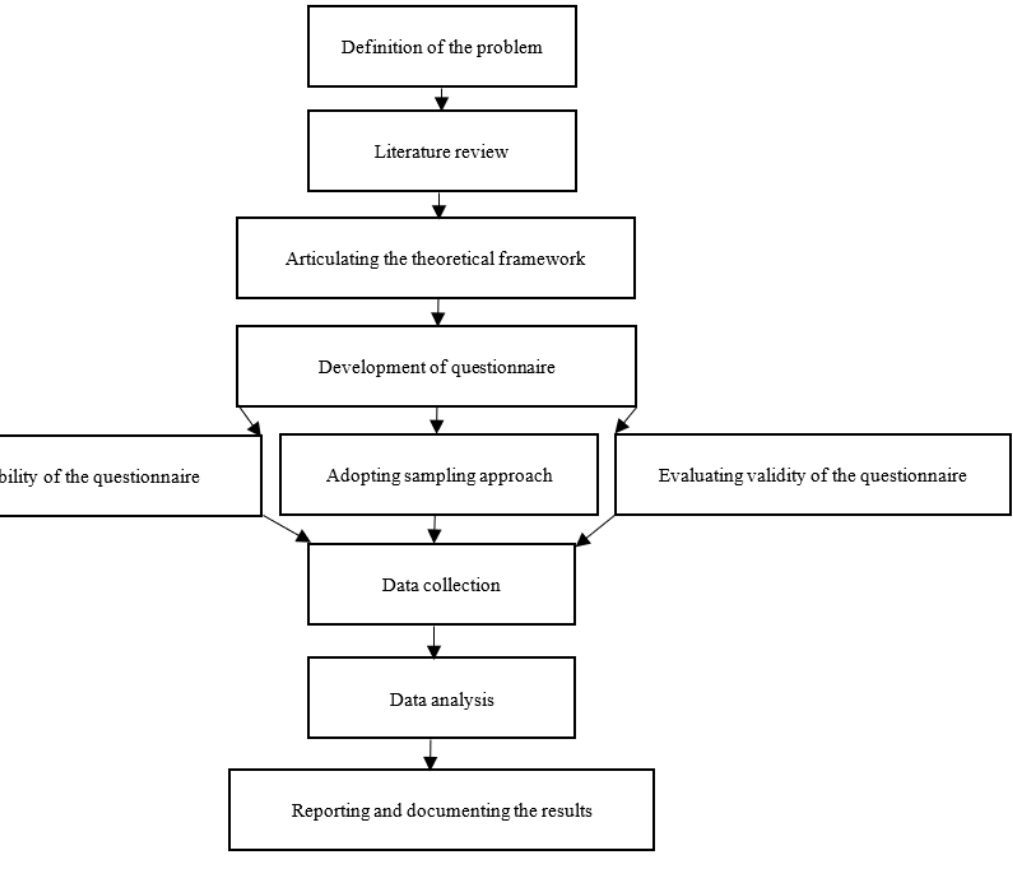
Figure 1. Research procedure and process.